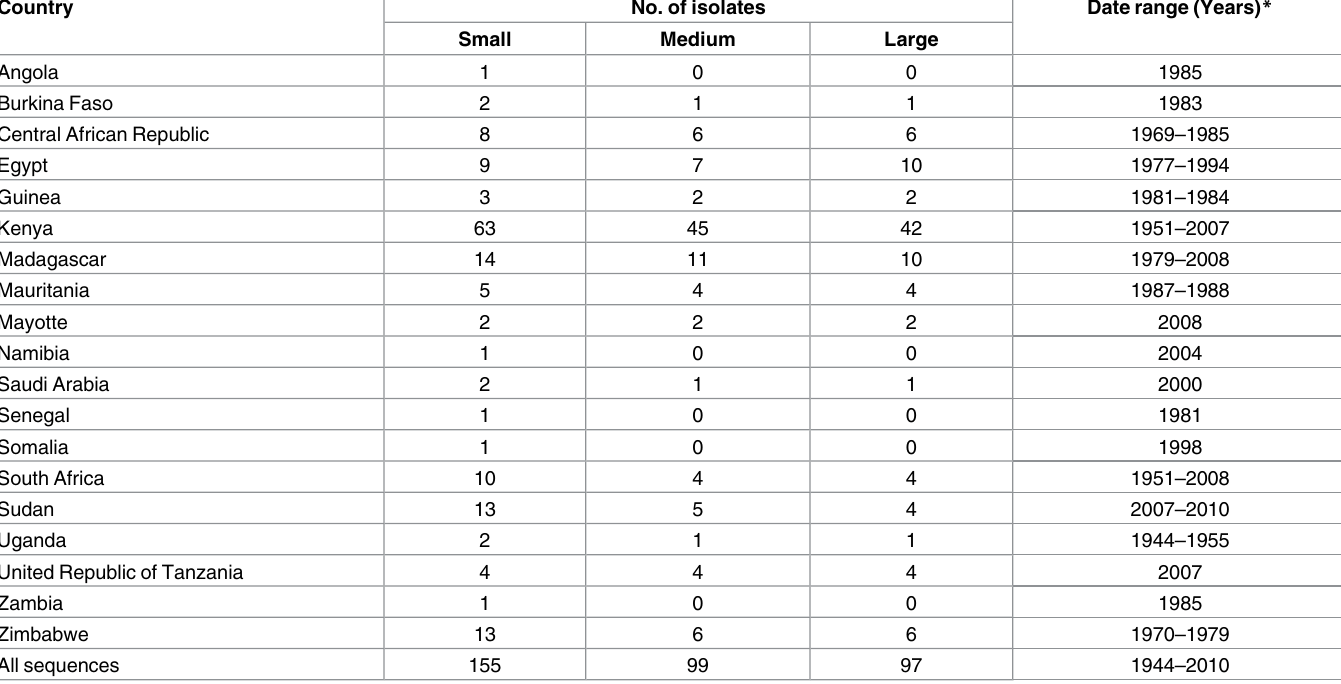
Table 1. Countries and dates of sampling available for the complete sequences of the small, medium, and large segments of RVFV strains across Africa, and Arabian Peninsula. Country